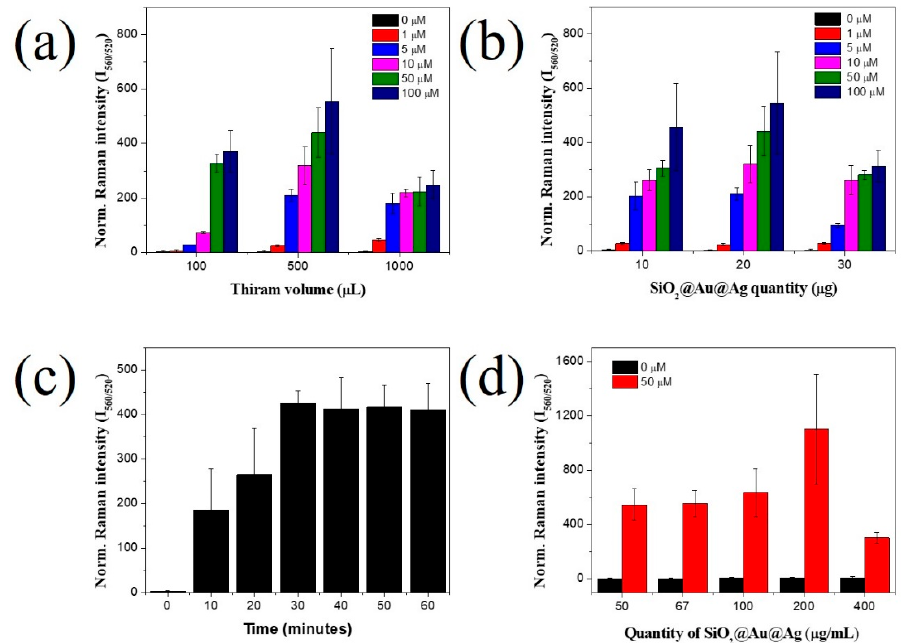
ff ect of ( a ) thiram volume, ( b ) quantity of SiO Figure 4. Effect of ( a ) thiram volume, ( b ) quantity of SiO 2 @Au@4-MBA@Ag, ( c ) incubation time, and Figure 4. E